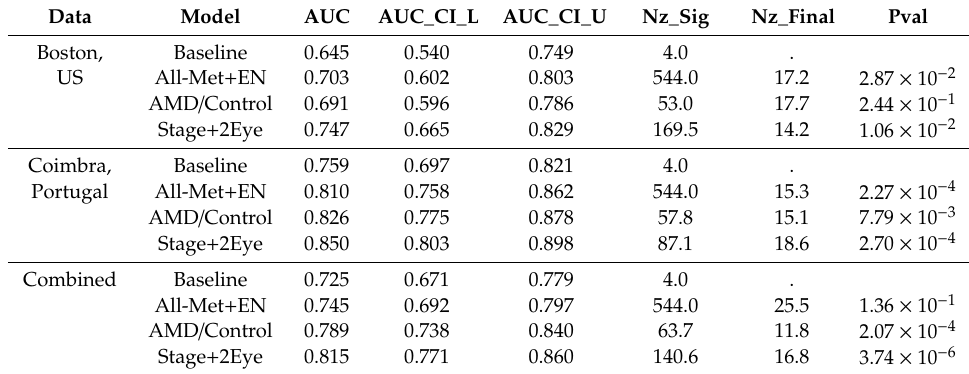
Table 4. Area under the curve (AUC) for predictive models for AMD including demographic covariates and significant metabolites identified in the AMD / Control and Stage + 2Eye models.